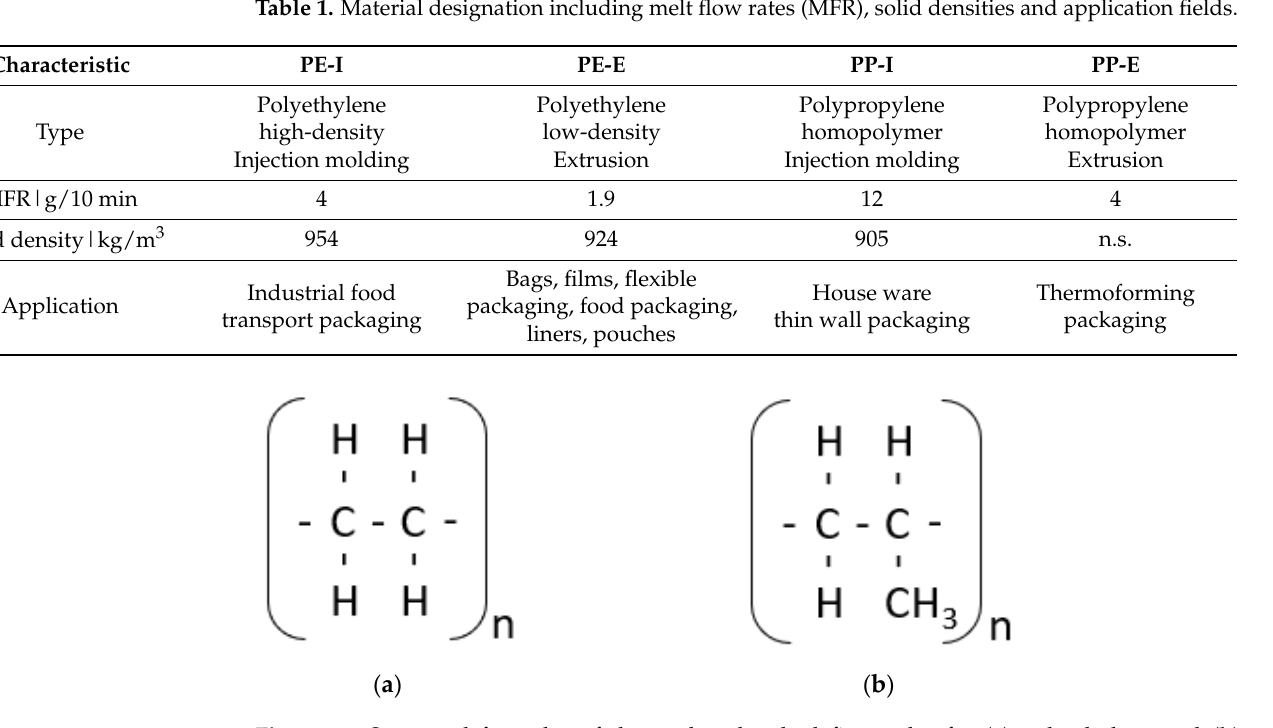
Figure 1. Structural formulas of the analyzed polyolefin grades for ( a ) polyethylene and ( b ) poly-propylene. Table 1. Material designation including melt flow rates (MFR), solid densities and application fields.